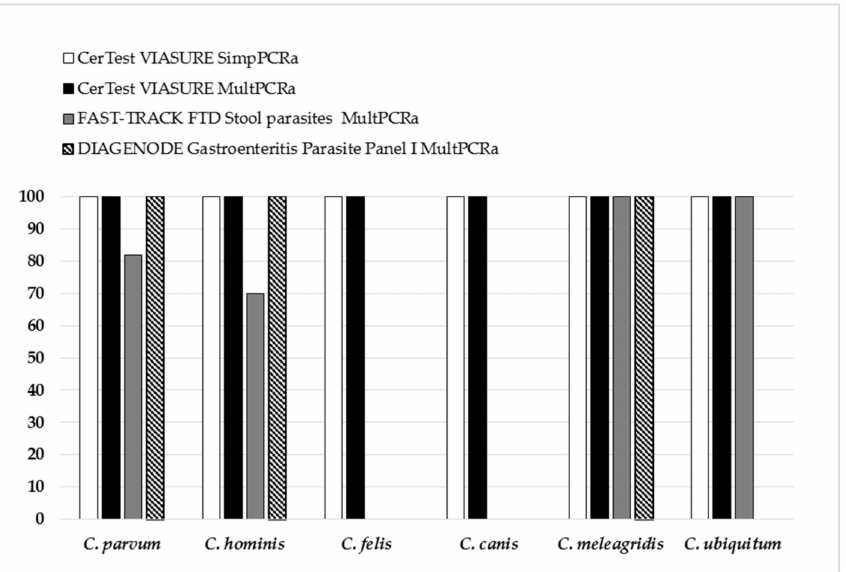
Figure 3. Performance (sensitivity) of the commercial PCR assays for the detection of Cryptosporidium spp. ( C. parum, n = 10; C. hominis, n = 10; C. felis, n = 4; C. canis, n = 2; C. meleagridis, n = 2; C. ubiquitum, n =